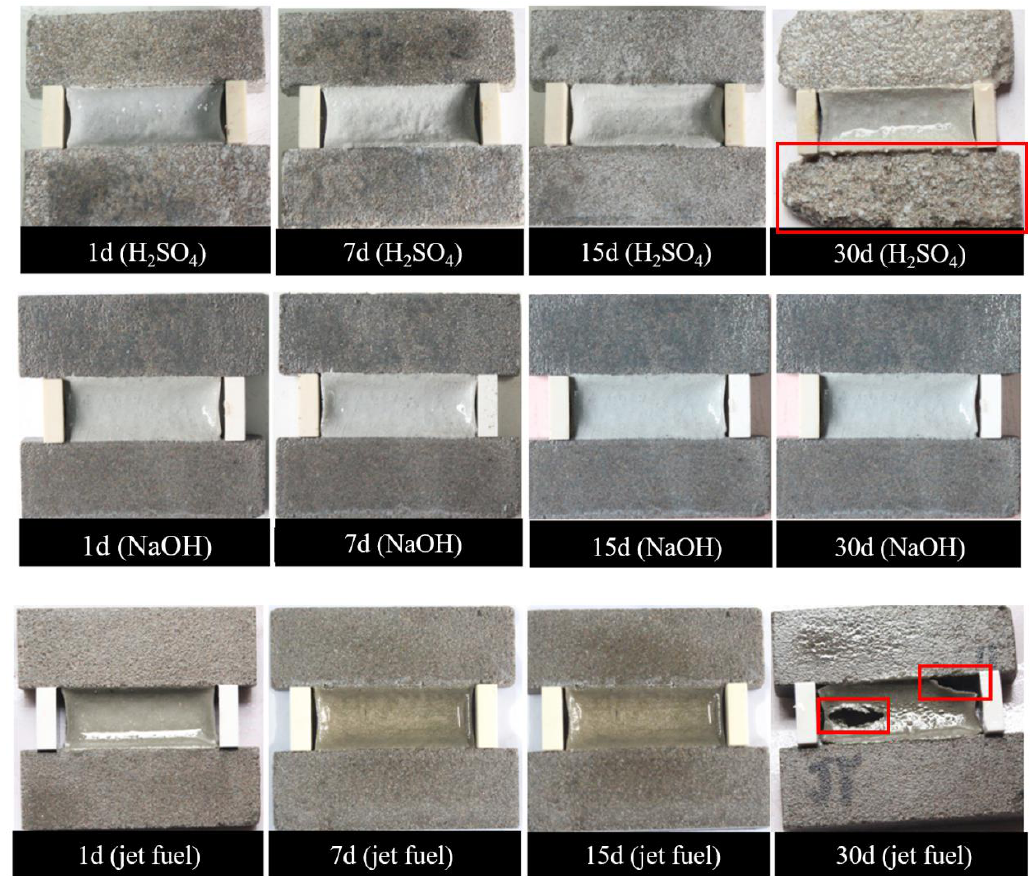
Figure 11. Fixed elongation morphology characteristics of PCFC under different corrosion solution immersion time. Materials 2020 , 13 , x FOR PEER REVIEW